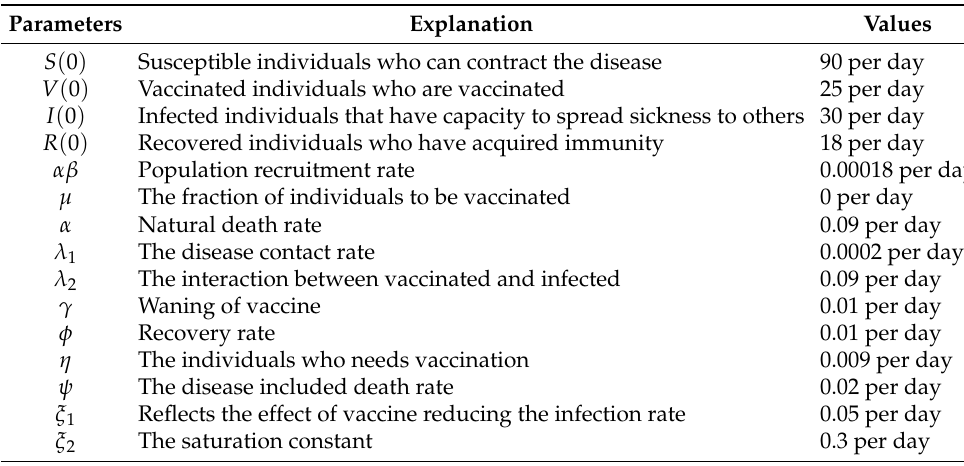
Figure 1. The flow chart and graphical representation of the proposed model. Table 1. The explanation of the parameters with their values is contained in the